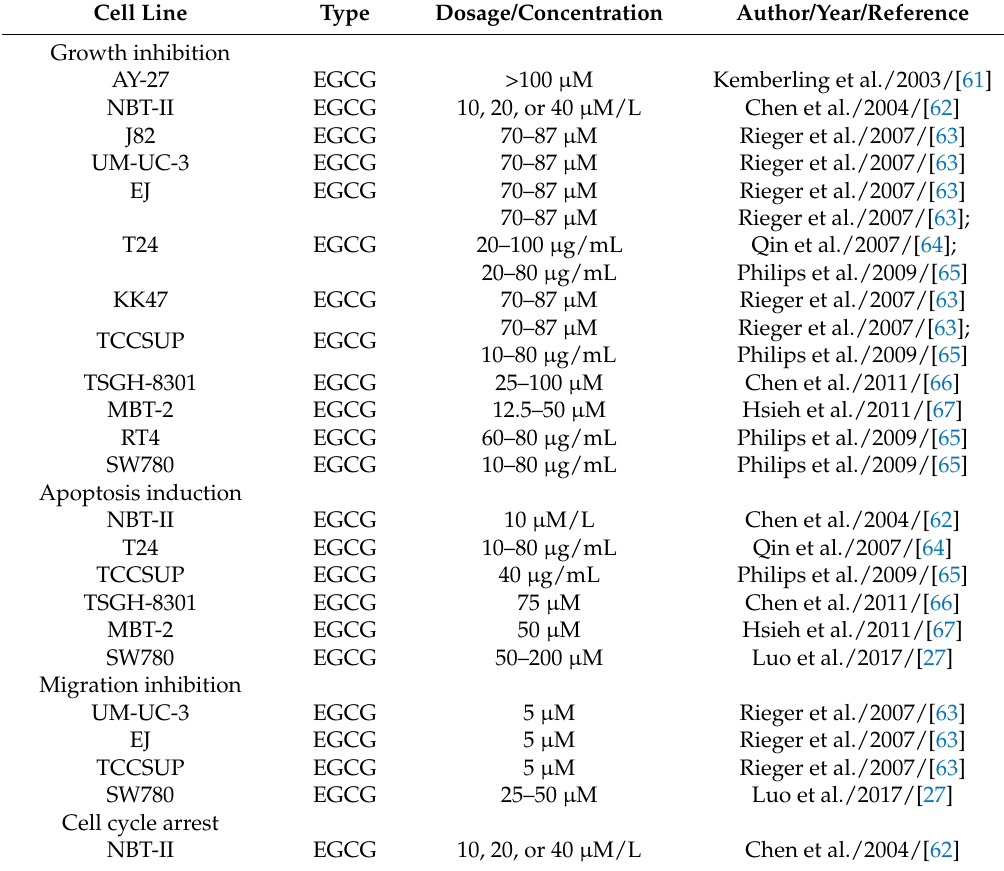
Table 3. Relationships between green tea polyphenol treatment and various cancer-related functions in in vitro studies of bladder cancer cell